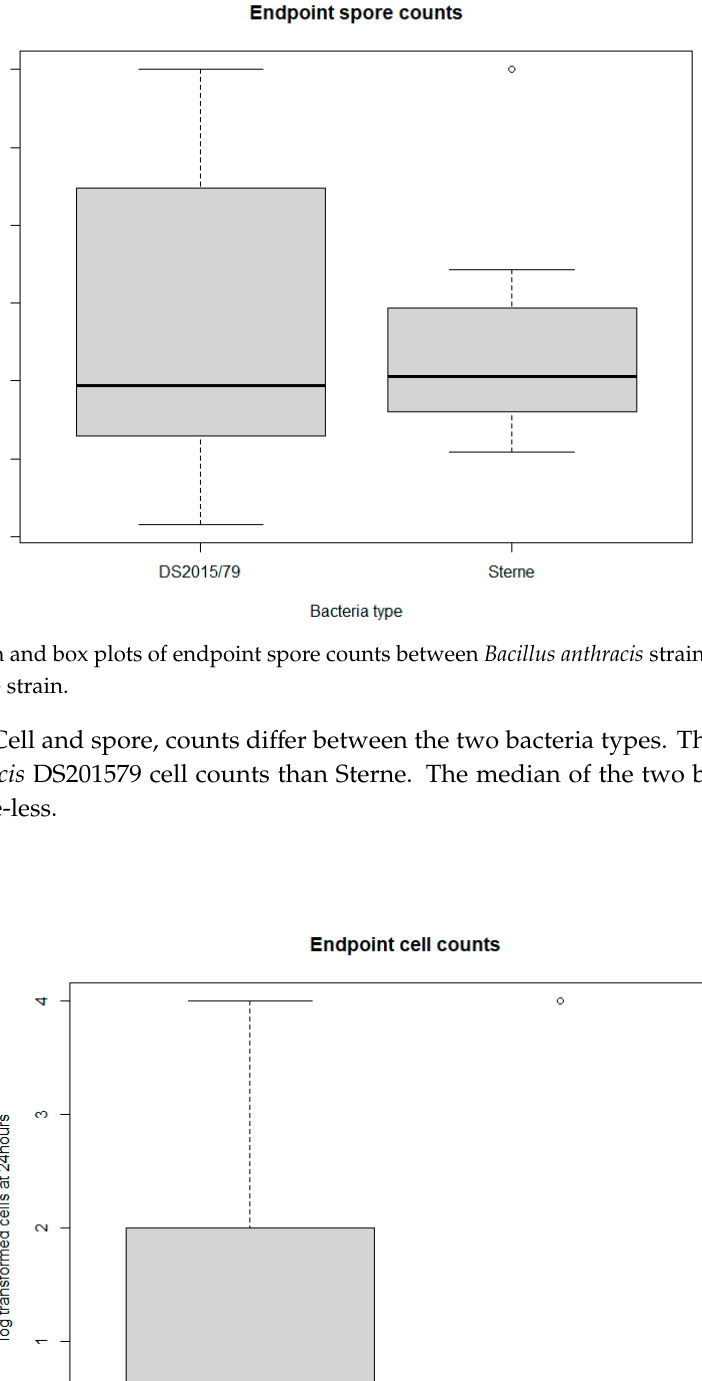
Figure A1: Average change in spores and cell counts do not seem to inherently di ff er between the two bacteria types namely encapsulates Bacillus anthracis 201579 and un-encapsulates B. anthracis 34F2 Sterne strain.